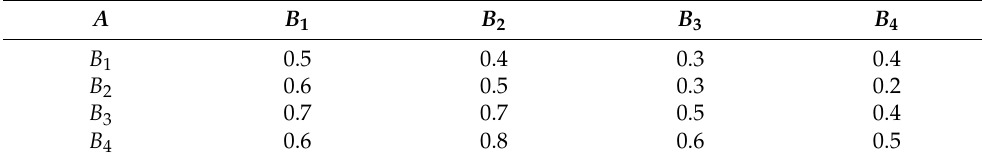
Table A22. Fuzzy symmetric matrix corresponding to first level index.